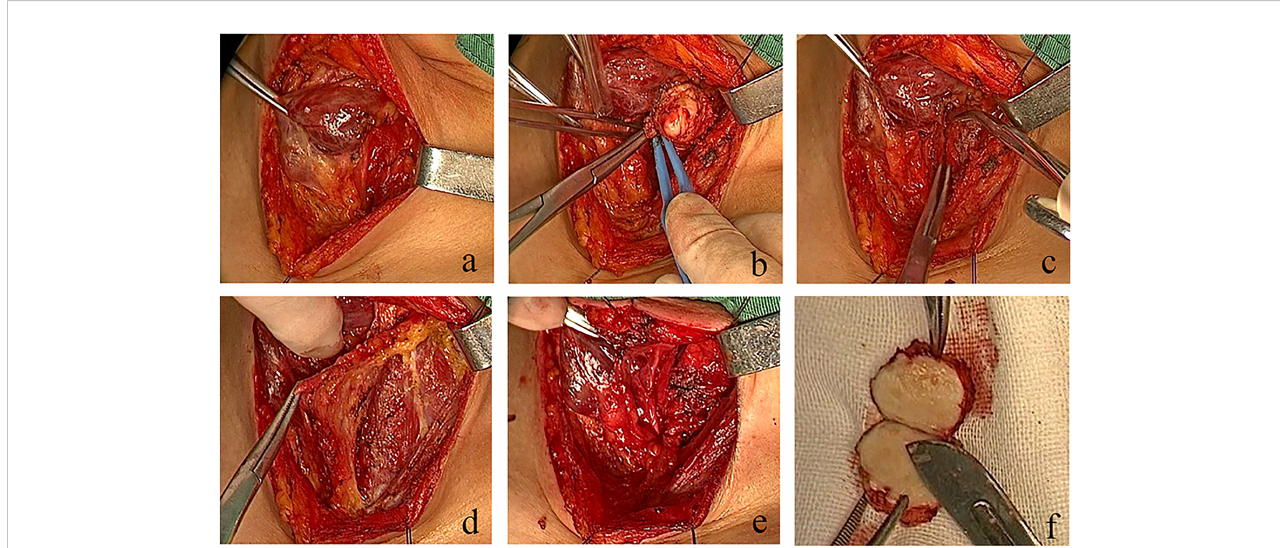
FIGURE 4 Real-time video of the operation process. In the case presented in this study, the defect was repaired by suturing the two lateral edges of the fascial tissue fl ap with the end of second to fourth tracheal rings and soft tissue in opposite positions. (A) Lateral freeing of the left thyroid gland, protection of the superior and inferior parathyroid glands, and the recurrent laryngeal nerve to expose the tumor. (B) Complete resection of the tracheal membrane tumor. (C) Tracheal membrane defect. (D) Preparation of a double-tipped banded myofascial fl ap. (E) No damage to the thyroid gland and recurrent laryngeal nerve after repair. (F) Specimen presentation.